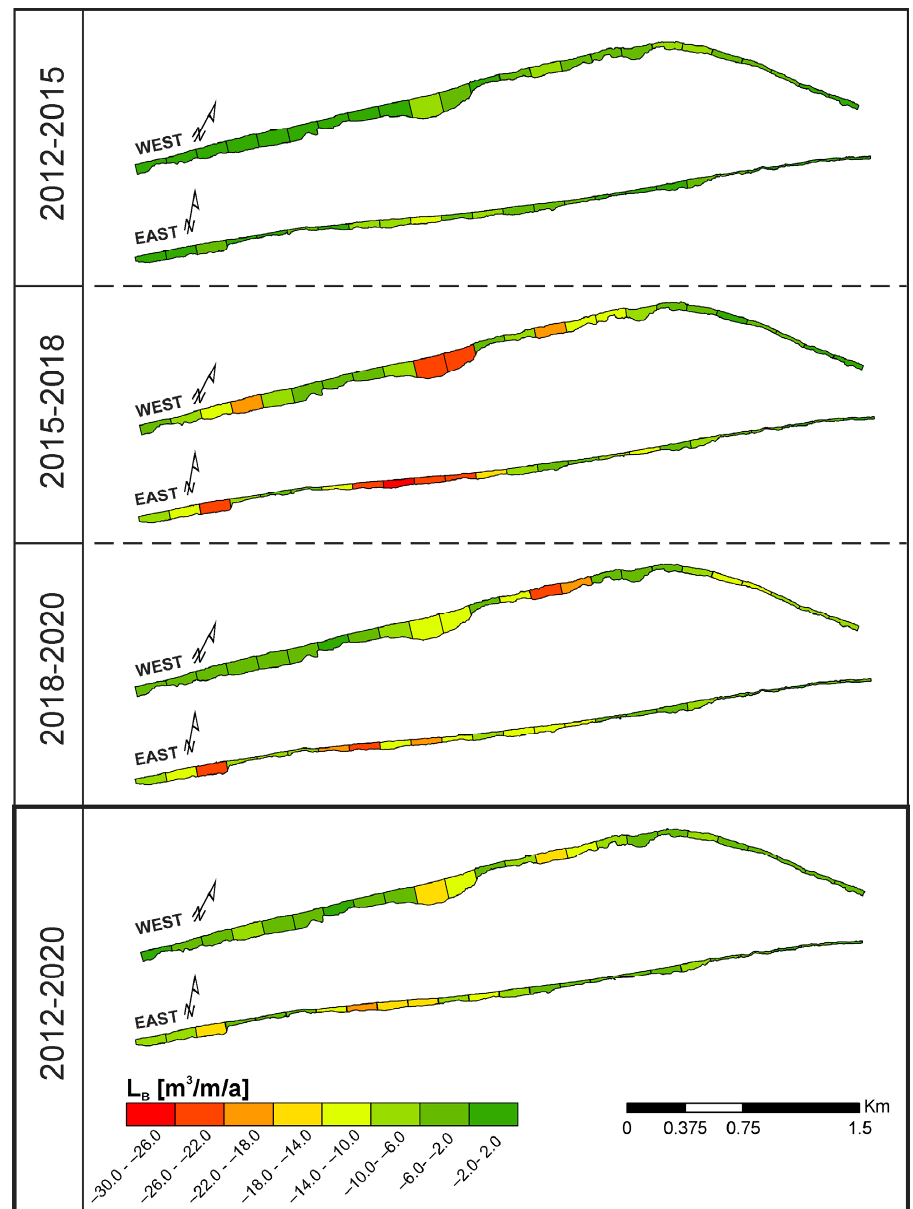
Figure 8. Figure showing the spatial distribution of the L B index in analyzed sectors in all research periods. Raw data source—Maritime Office in Szczecin.